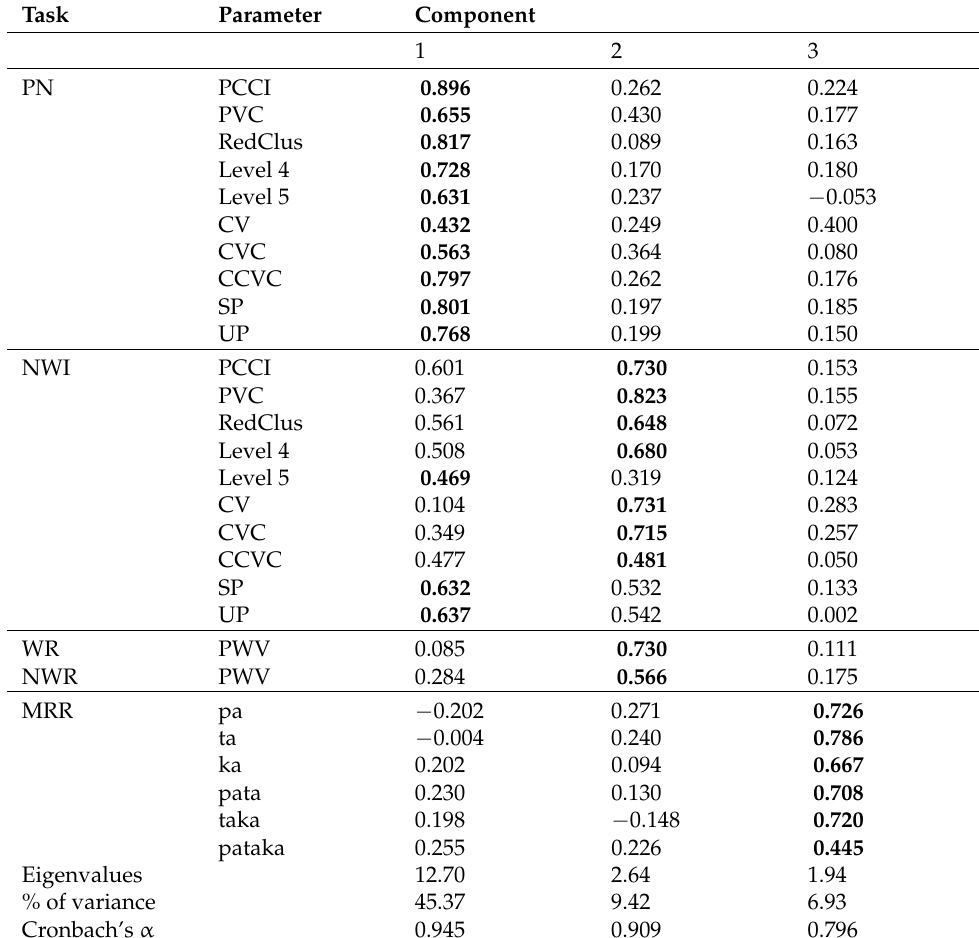
Table 2. Principal Component Analysis results for Picture Naming (PN), NonWord Imitation (NWI), Word (WR) and NonWord (NWR) Repetition, and Maximum Repetition Rate (MRR). The highest component loading of each parameter is displayed in